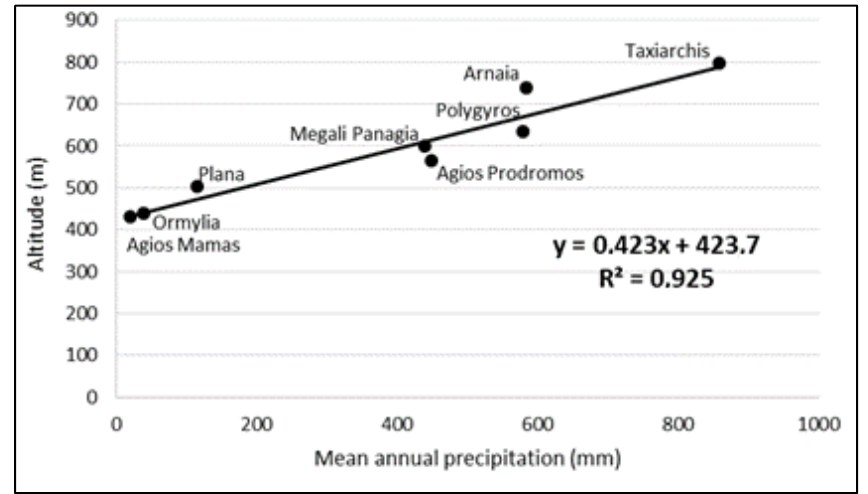
Figure 8. Relation between mean annual precipitation and altitude.